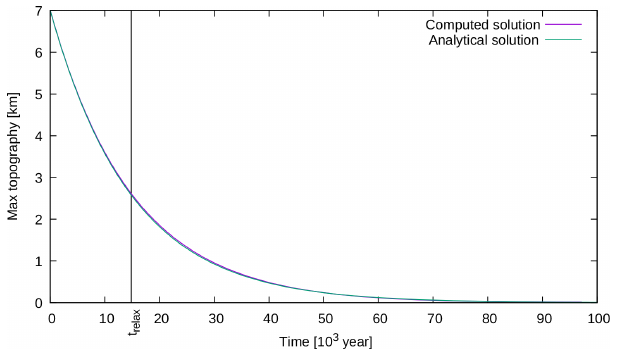
Figure D2. Comparison between the analytical and numerical re- sults of the maximum topography over time for the free surface benchmark.